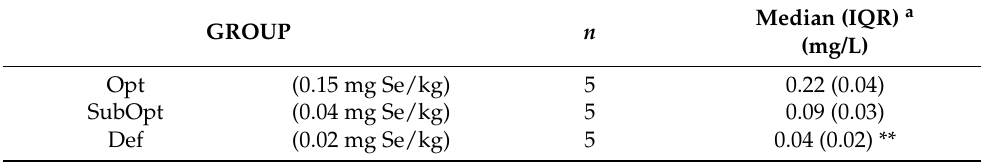
Table 3. Se plasma levels in offspring at weaning (PND 23).